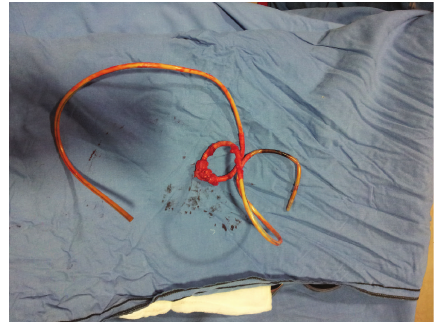
Figure 4: The entire foreign body after its